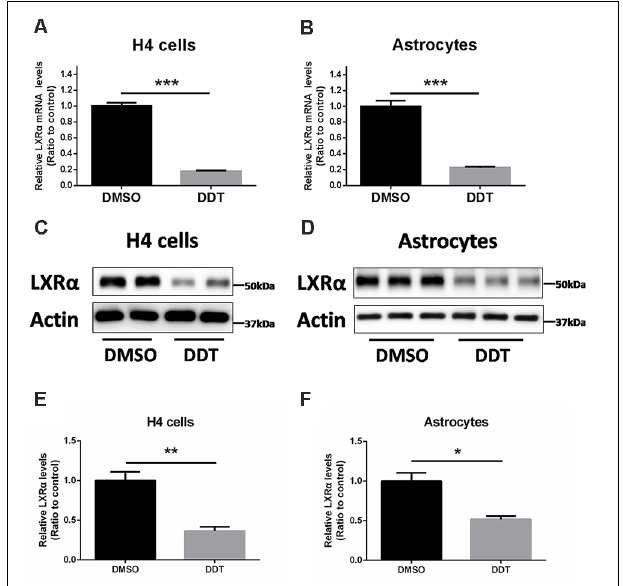
FIGURE 3 | DDT decreases liver X receptor α (LXR α ) mRNA and protein levels in H4 human neuroglioma cells and immortalized astrocytes. (A) LXR α mRNA expression in H4 human neuroglioma cells; (B) LXR α mRNA expression in immortalized astrocytes; (C) LXR α protein expression in H4 human neuroglioma cells; (D) LXR α protein expression in immortalized astrocytes; (E) semiquantitative analysis of LXR α protein expression in H4 human neuroglioma cells; (F) semiquantitative analysis of LXR α protein expression in immortalized astrocytes. Mean ± SEM, n = 4–6, * P < 0.05 vs. control, ** P < 0.01 vs. control, *** P < 0.001 vs. DMSO control